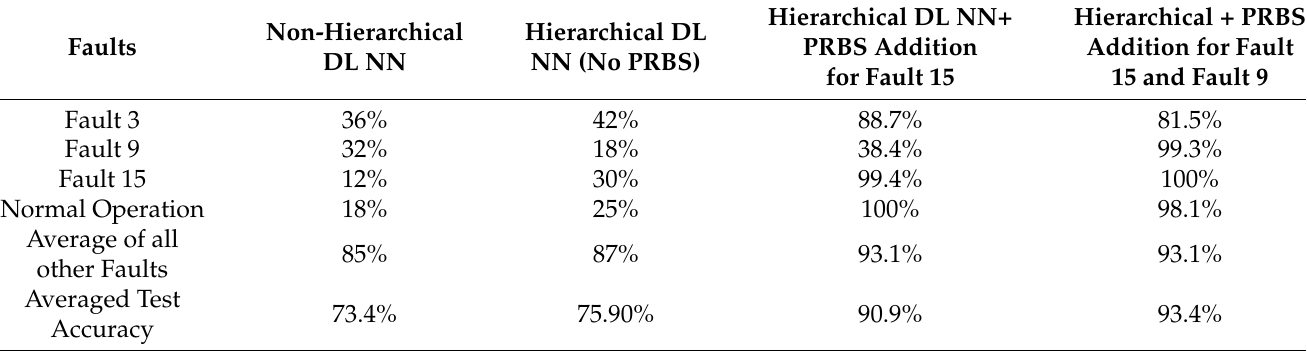
Table 5. Ablation study for the proposed method.